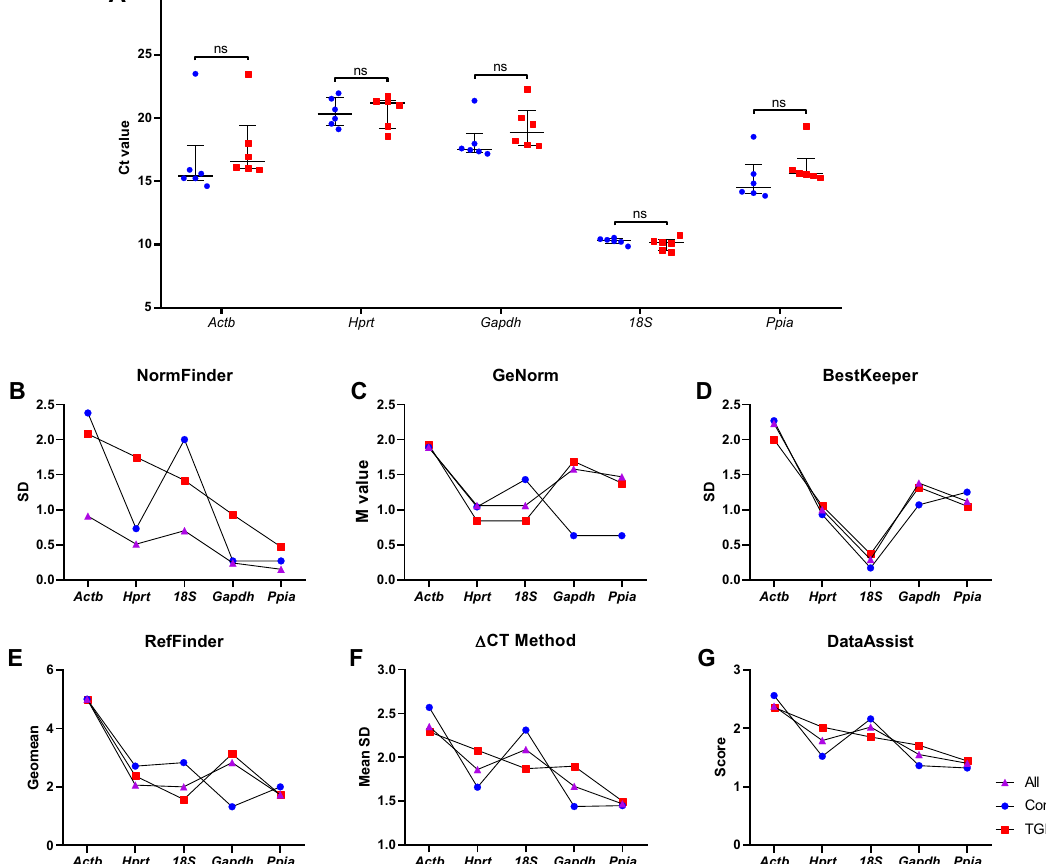
Figure 2. Ct values of five candidate housekeeping genes ( A ) and stability analysis of housekeeping genes by six different software ( B–G ). A lower cycle threshold (Ct) value indicates a higher gene expression ( A ). The median values are expressed as horizontal lines, and the error bars represent the interquartile range. The Ct values of 18S were the lowest, indicating the highest expression levels. Best housekeeping gene for each group of samples yielded by software analysis ( B–G ). All, all samples. ns, non-significant.